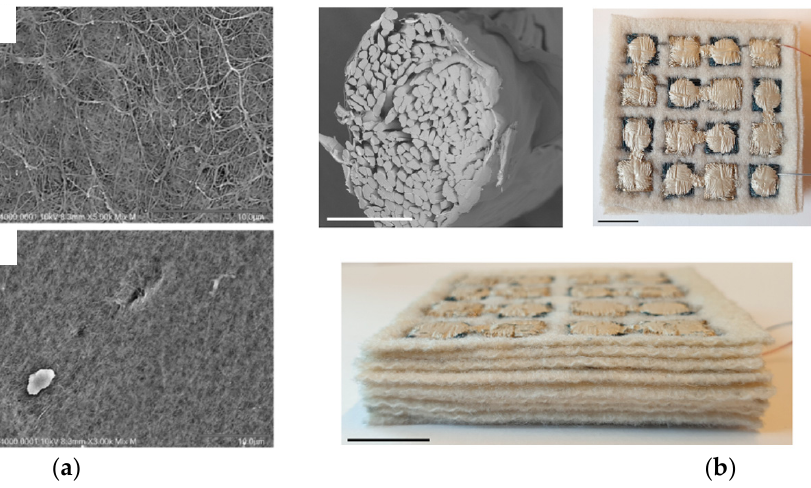
Figure 9. Examples of recent developments toward thermoelectric energy harvesting materials and structures for textile application: ( a ) MWCNT film before and after doping with PEI, used respectively as the p- and n-type thermoelectric legs (reproduced from [132] with permission from ACS Publications); ( b ) DMSO/PEDOT: PSS coated silk yarn used to prepare an out-of-plane thermoelectric device (reproduced from [138], available through the Creative Commons license (crea- tivecommons.org/licenses/by/4.0/)).